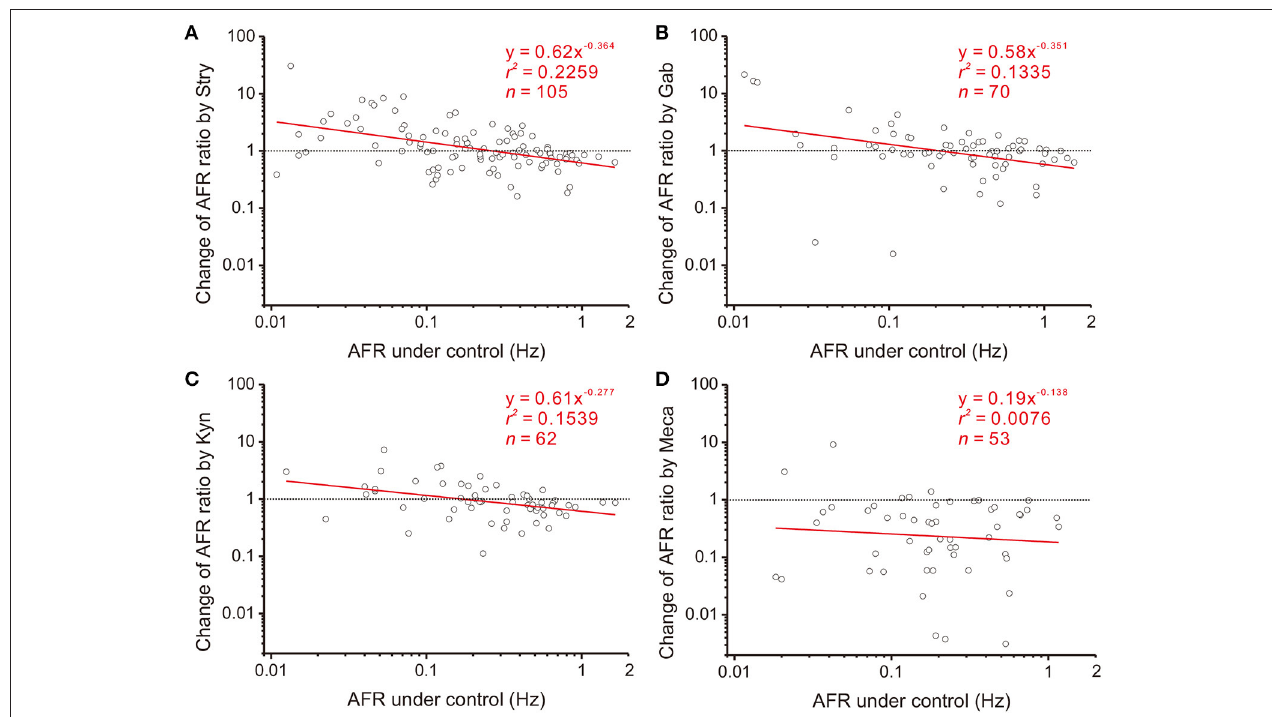
FIGURE 4 | Involvement of endogenous receptor activities in power-law firing modulation (plFM). The log-log plots show the data obtained from bath applications of 2 µ M strychnine (Stry, a glycine receptor blocker; A ), 20 µ M gabazine (Gab, a GABA A receptor blocker; B ), 400 µ M kynurenate (Kyn, a broad-spectrum ionotropic glutamate receptor blocker; C ), and 1 µ M mecamylamine (Meca, a nicotinic receptor blocker; D ). Applications of Stry, Gab, or Kyn caused the plFM. Applications of Meca largely reduced AFR and did not cause the plFM. Significance of regression: P < 0.00001 in (A) , P < 0.005 in (B,C) and P = 0.5389 in (D) . CI b : (A) − 0.515 to − 0.213, (B) − 0.600 to − 0.102, (C) − 0.470 to − 0.084, and (D) − 0.648 to